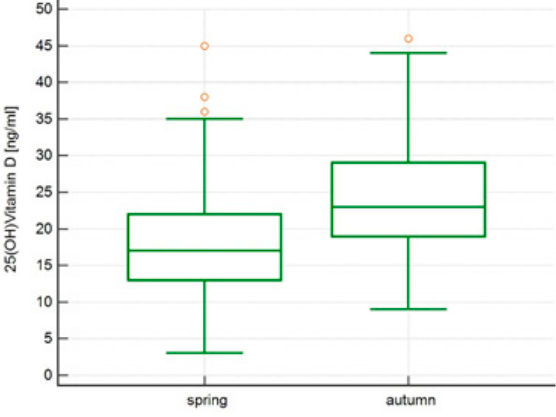
Figure 1. Vitamin D concentrations [ng/mL] in spring vs autumn.